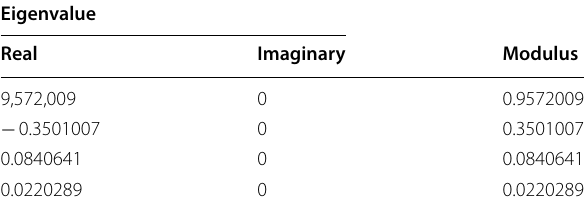
Table 4 Eigenvalue stability